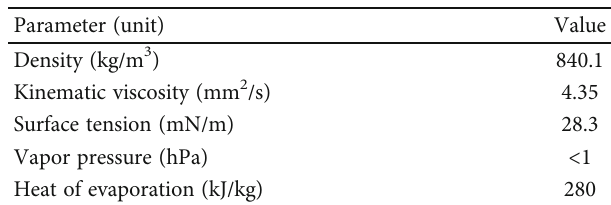
Figure 4: Real time image of the spray experiment. Table 2: Properties of diesel (at 298 K).